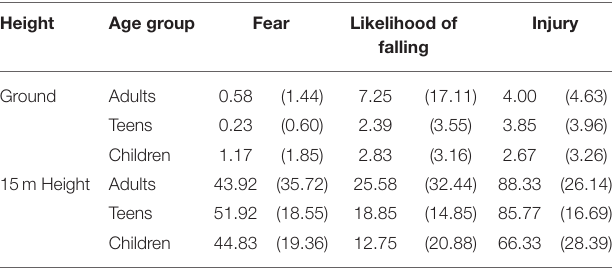
TABLE 2 | Means (SD) of risk questions in Experiment